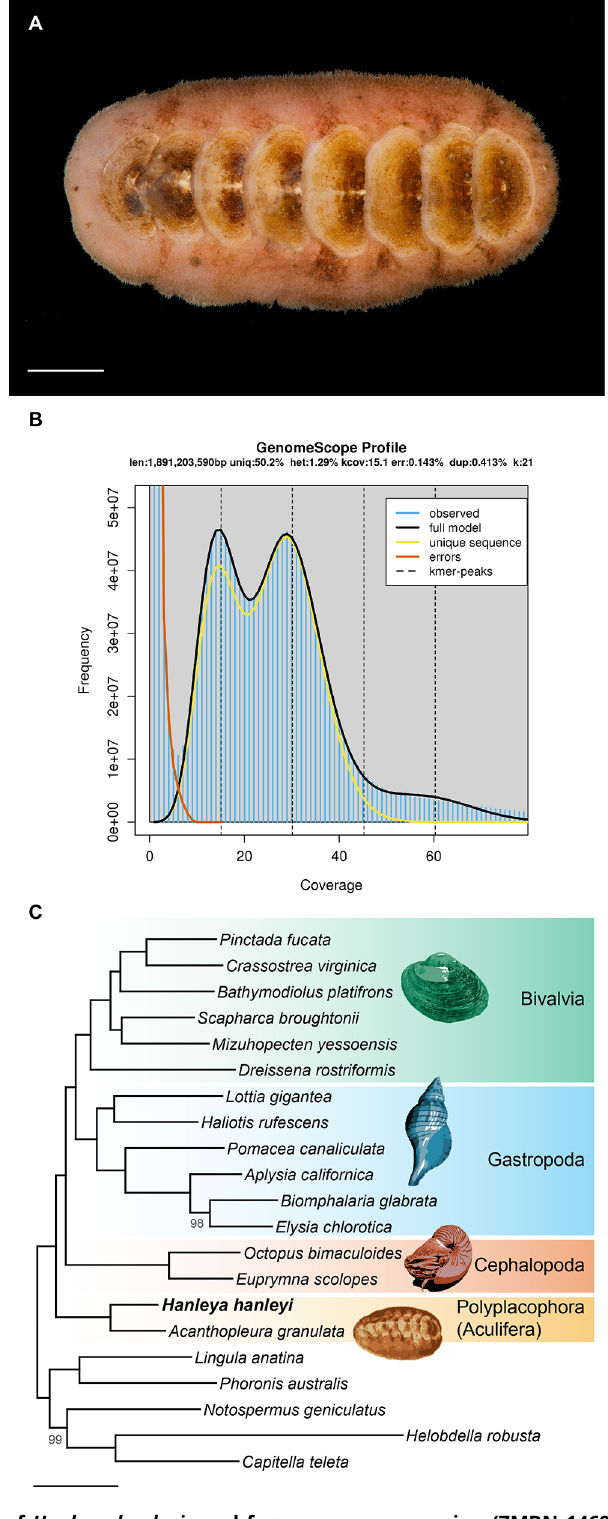
Figure 1. A. Specimen of Hanleya hanleyi used for genome sequencing (ZMBN 146951). Scale bar = 8 mm. B. GenomeScope analysis of the paired-end Illumina data. The presence of two peaks indicates that Hanleya has a diploid genome, as expected. Heterozygosity is measured via k-mer distribution (presented at top of graph as “ het ” ). C. Phylogenetic analysis of 2,331 nuclear protein-coding genes. Bootstrap support values below 100 are displayed at each node. Scale bar = 0.2 substitutions per